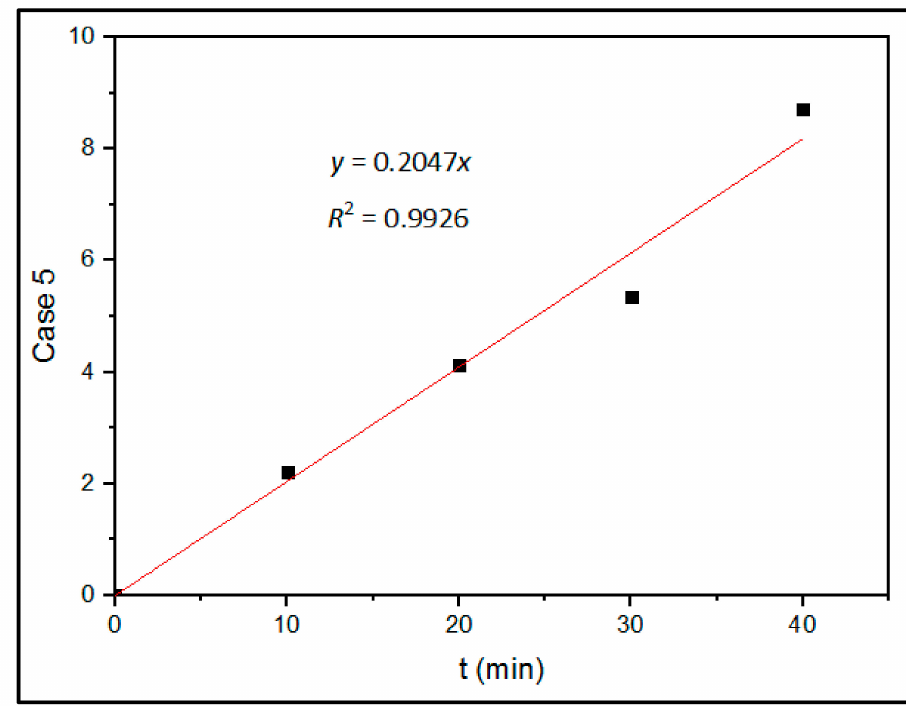
Figure 11. Best-fit kinetic plot for MOOME